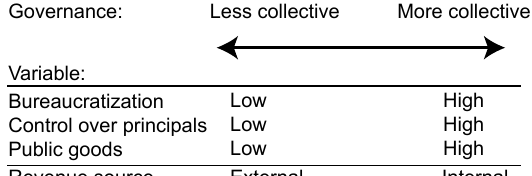
Fig. 6 Processes of collective governance.